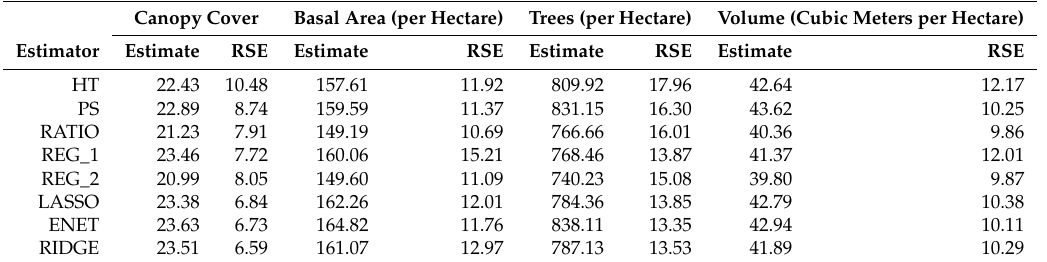
Table 1. Mean estimates (Estimate) and relative standard errors (RSE) for the quantitative forest variables.